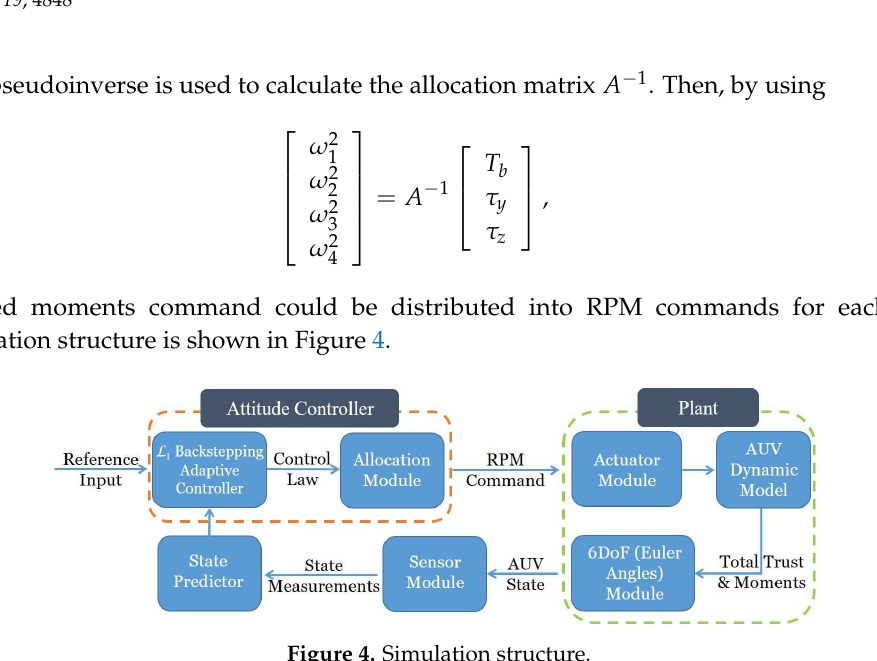
Figure 4. Simulation structure.